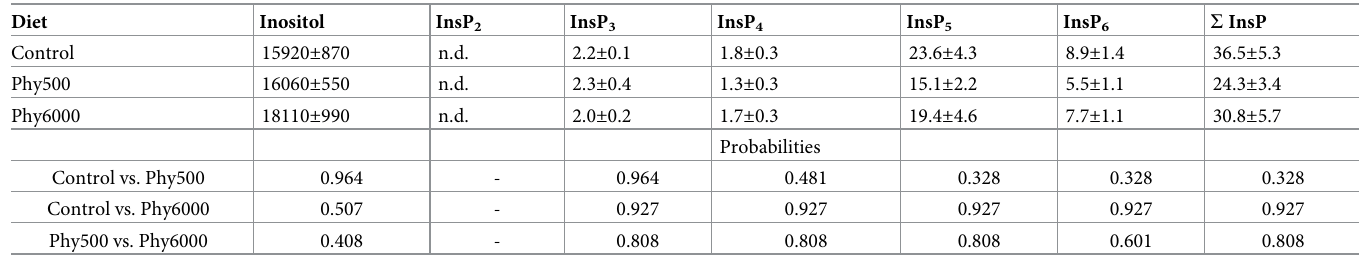
Table 6. Inositol and inositol phosphate (InsP 2-6 ) levels (nmol/g wwt) in liver of day 21 broilers 1,2 .